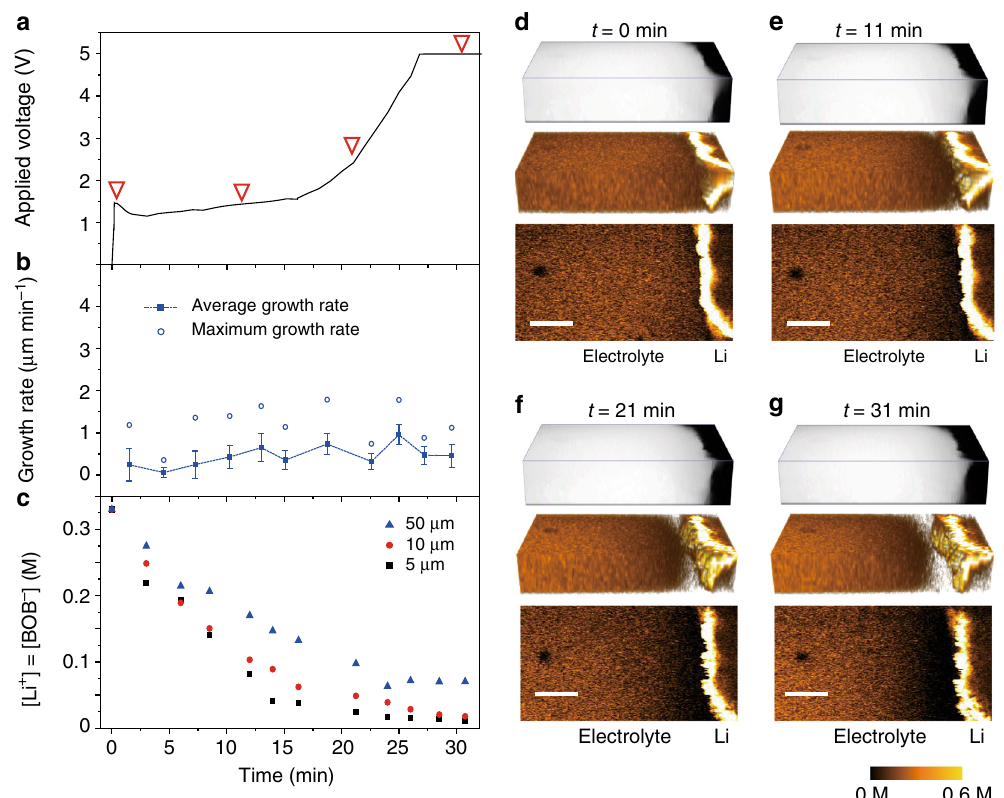
Fig. 5 SRS analysis of a Li 3 PO 4 -coated Li electrode. a Voltage pro fi le of a Li 3 PO 4 -coated Li – Li cell showing the voltage change vs. time. b Average growth rate and standard deviation versus time (same sizes as above). c Concentration change at 5 μ m, 10 μ m and 50 μ m away from the electrode surface. d – g Correspond to 0 min, 11 min, 21 min and 31 min, respectively. Each time set contains a 3D image, 3D SRS image, and representative 2D SRS image from top to bottom. The depletion region in all 3D SRS images is represented by a transparent white area to enhance the visual